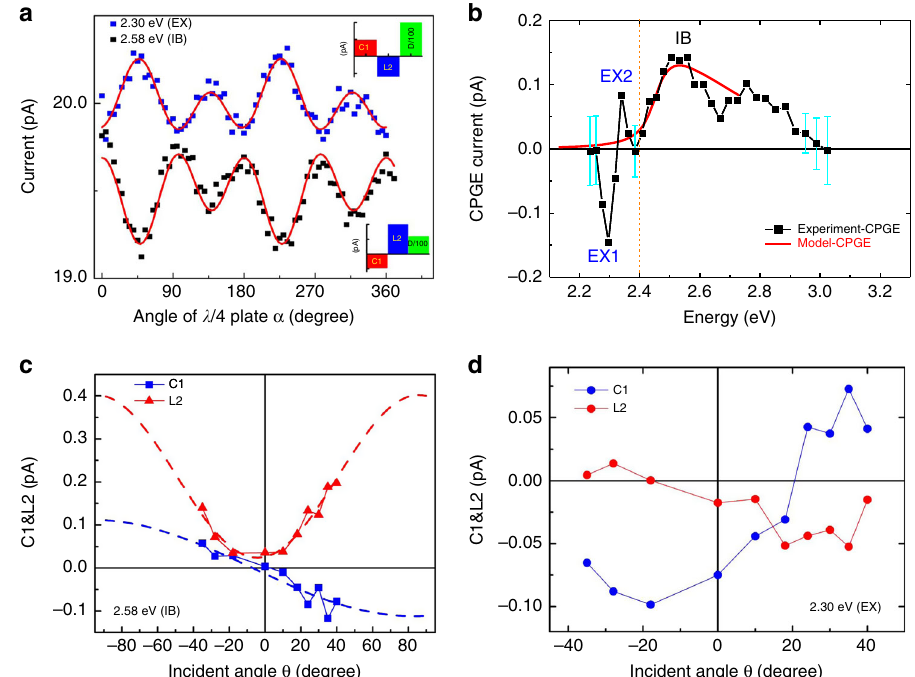
Fig. 2 Continuous-wave (CW) photogalvanic (PGE) currents in 2D-PEPI crystal. a The room temperature photogalvanic current in 2D-PEPI crystal vs. λ / 4 plate rotation angle, α measured at θ = 30°, excited at resonance with the exciton (blue squares) and interband (black squares) that is shifted vertically for clarity. The red lines through the data points are fi ts using Eq. (1) with fi tting parameters C1 , D , and L2 shown in the insets. b The CPGE ( C1 ) action spectrum of 2D-PEPI crystal (black squares); the red line through the data points is a fi t using a four bands model (see text). The error bars (cyan, s.e.m.) indicate the uncertainty of special data points close to zero. C1( ω ) spectrum is divided by a vertical broken line into two spectral ranges, exciton (EX) and interband (IB). The two exciton species are labeled as EX1 & EX2. c The CPGE amplitude, C1 (blue squares) and LPGE amplitude, L2 (red triangles) vs. the incident angle, θ at resonant excitation with the interband (IB, at 2.58 eV). The broken lines are fi ttings (see text). d The incident angle θ dependence of C1 (blue circles) and L2 (red circles) at resonant excitation with the exciton (EX1, at 2.30